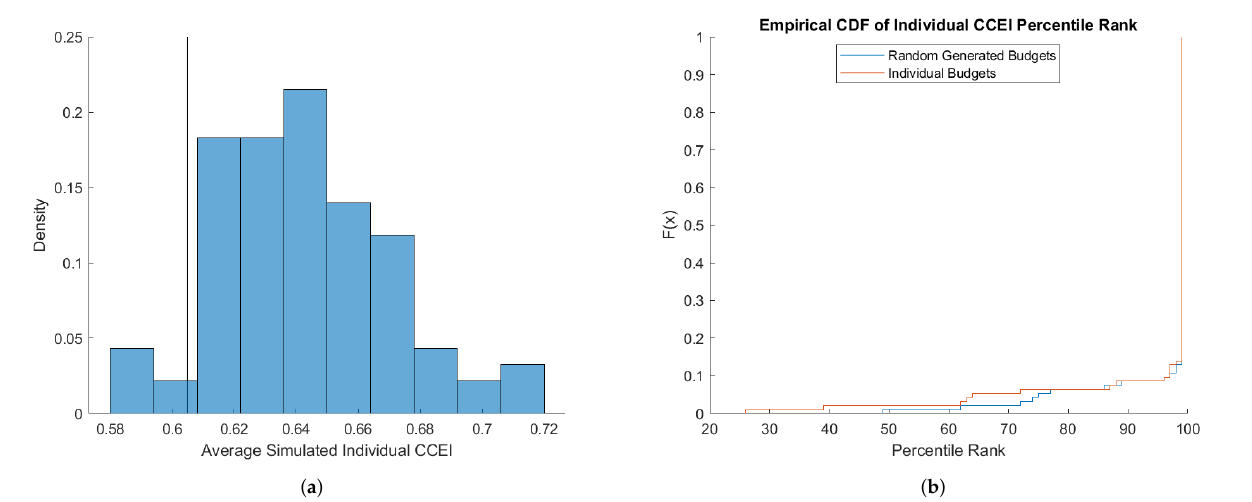
Figure 2. Simulation results for CCEI (CFGK). ( a ) Histogram, ( b ) Percentile Ranks.